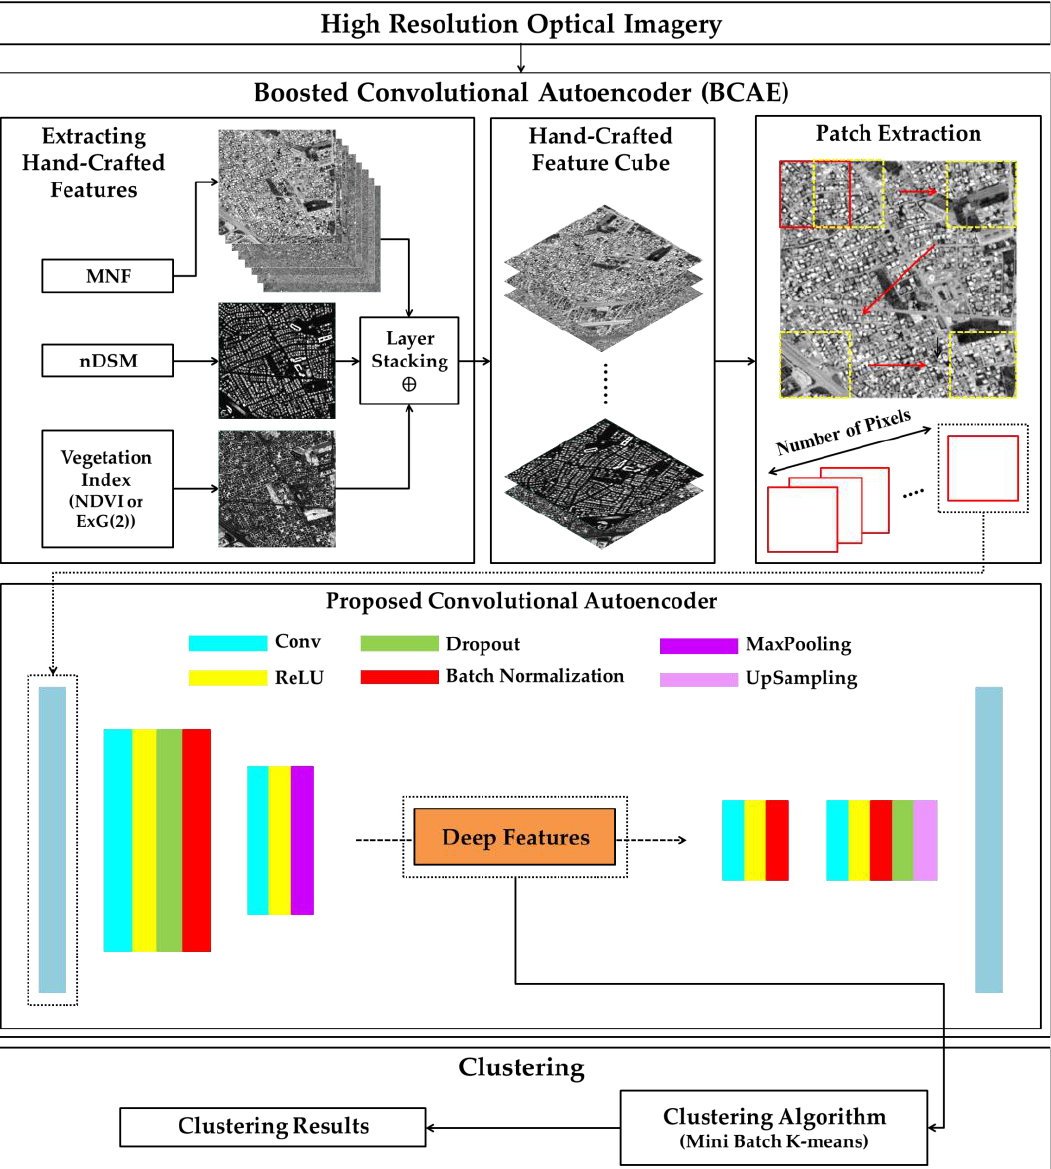
Figure 1. An overall overview of the proposed clustering method.